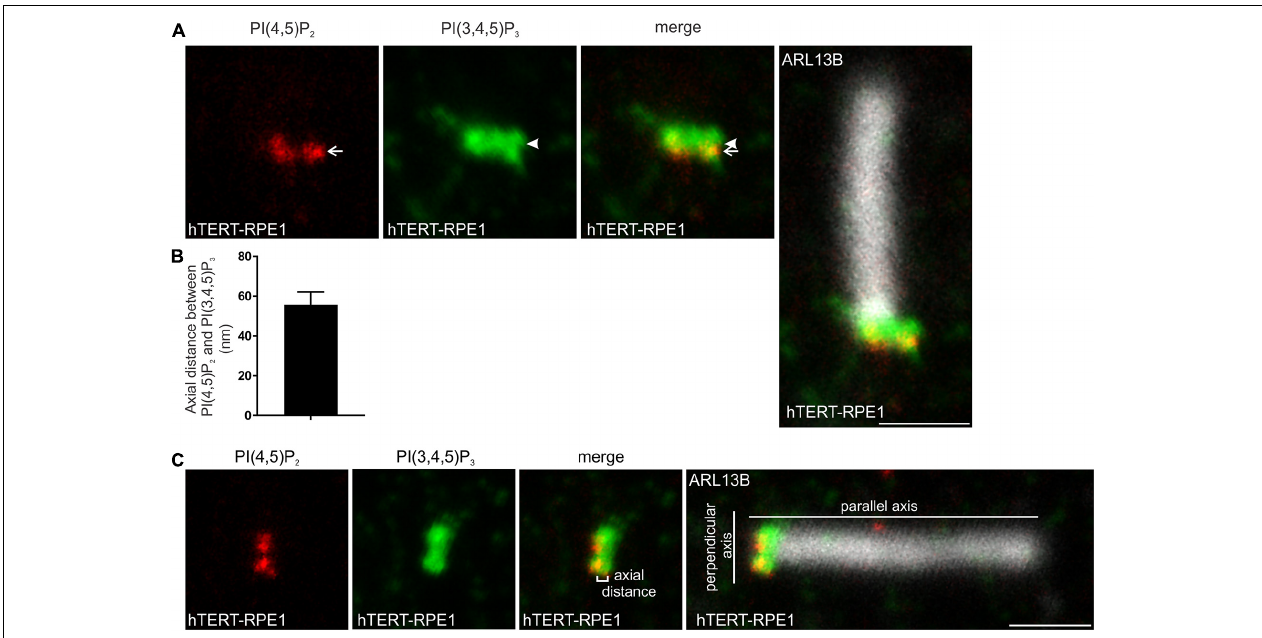
FIGURE 4 | PI(4,5)P 2 and PI(3,4,5)P 3 localize to distinct subdomains within the transition zone. (A) Ciliated hTERT-RPE1 cells were immunostained with PI(4,5)P 2 (red), PI(3,4,5)P 3 (green) and ARL13B (grayscale) antibodies and imaged by STED microscopy (confocal resolution image of the ARL13B stained axoneme is shown). Arrow indicates PI(4,5)P 2 transition zone signal and arrow head indicates PI(3,4,5)P 3 transition zone signal, bar indicates 1 µ m. (B) Graph shows the axial distance between the highest intensity point of the PI(4,5)P 2 and PI(3,4,5)P 3 signals parallel to the plane of the axoneme. Bars represent mean ± SEM, n = 3 independent experiments, 30 cilia imaged per experiment and all cilia with distinct PI(4,5)P 2 and PI(3,4,5)P 3 puncta measured. (C) Example image showing method for the axial distance measurements, bar indicates 1 µ